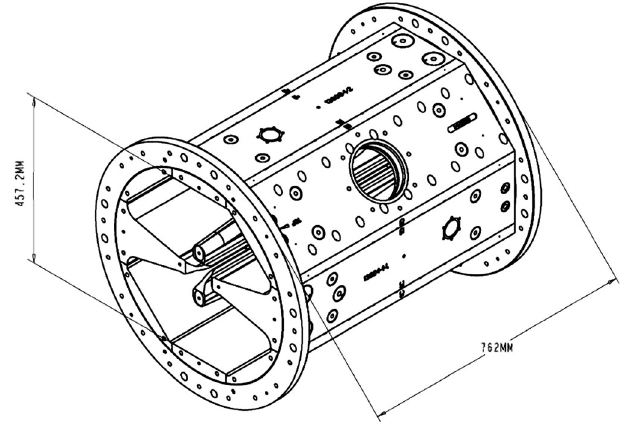
FIG. 7. CAD model of the first segment.